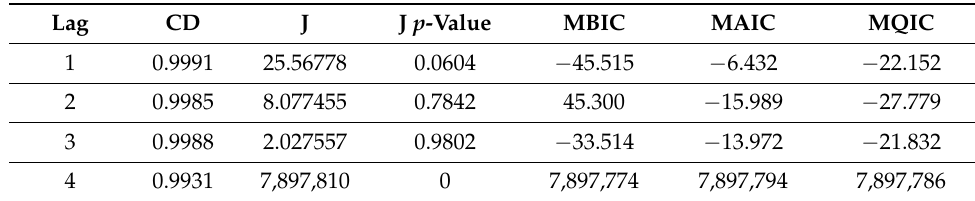
Table 4. Results of lag length selection procedure.